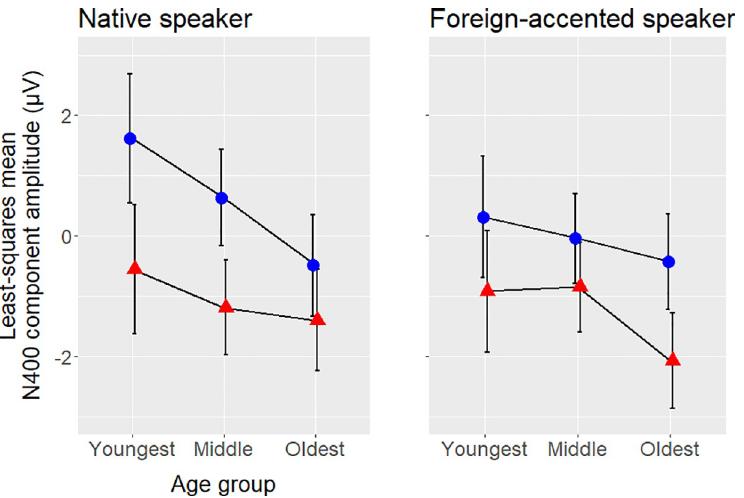
Fig 8. The relationship between N400 component amplitude and age for each speaker condition. Least-squares mean amplitude values for congruous sentences are shown as blue circles, least-squares mean amplitude values for incongruous sentences are shown as red triangles. Error bars show 95% confidence intervals. Youngest, middle and oldest age groups were defined as in the post-hoc analysis.